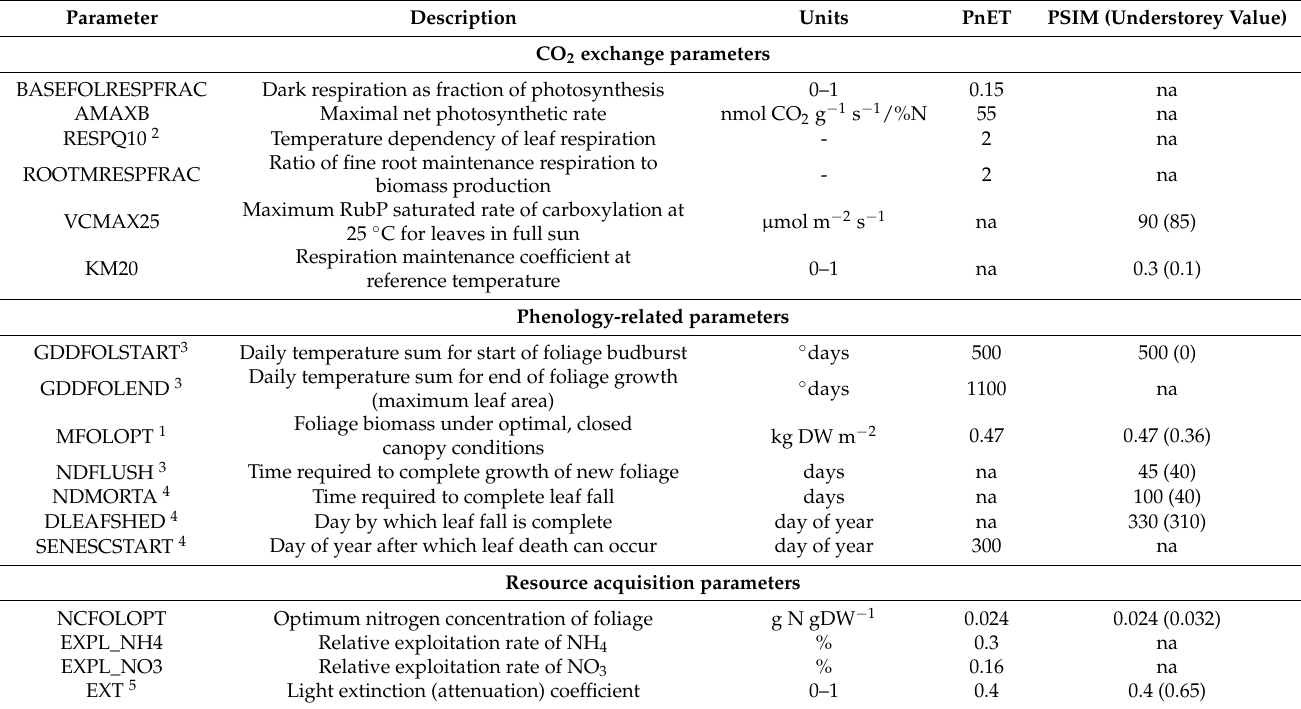
Table 3. LandscapeDNDC vegetation modules’ species parameters adjusted to simulate GHG fluxes for pedunculate oak at the Straits